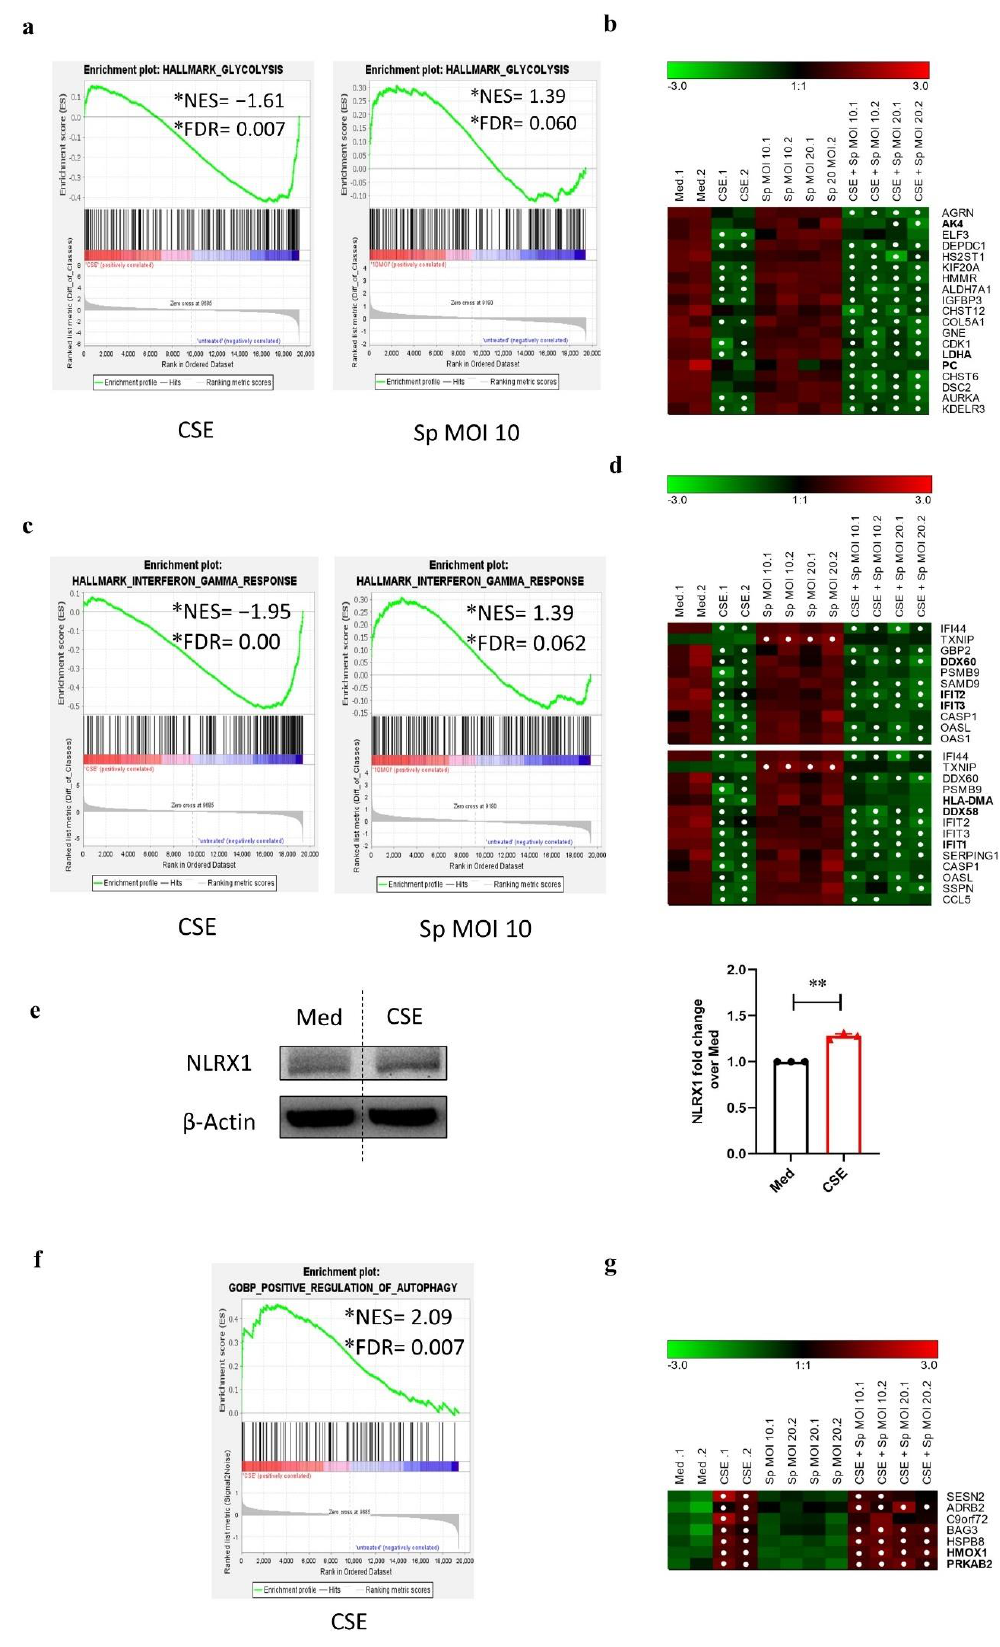
Figure 6. Gene expression and gene set enrichment analysis of 16HBE epithelial cell responses upon cigarette smoke extract stimulation and Streptococcus pneumoniae infection in 16HBE cells.